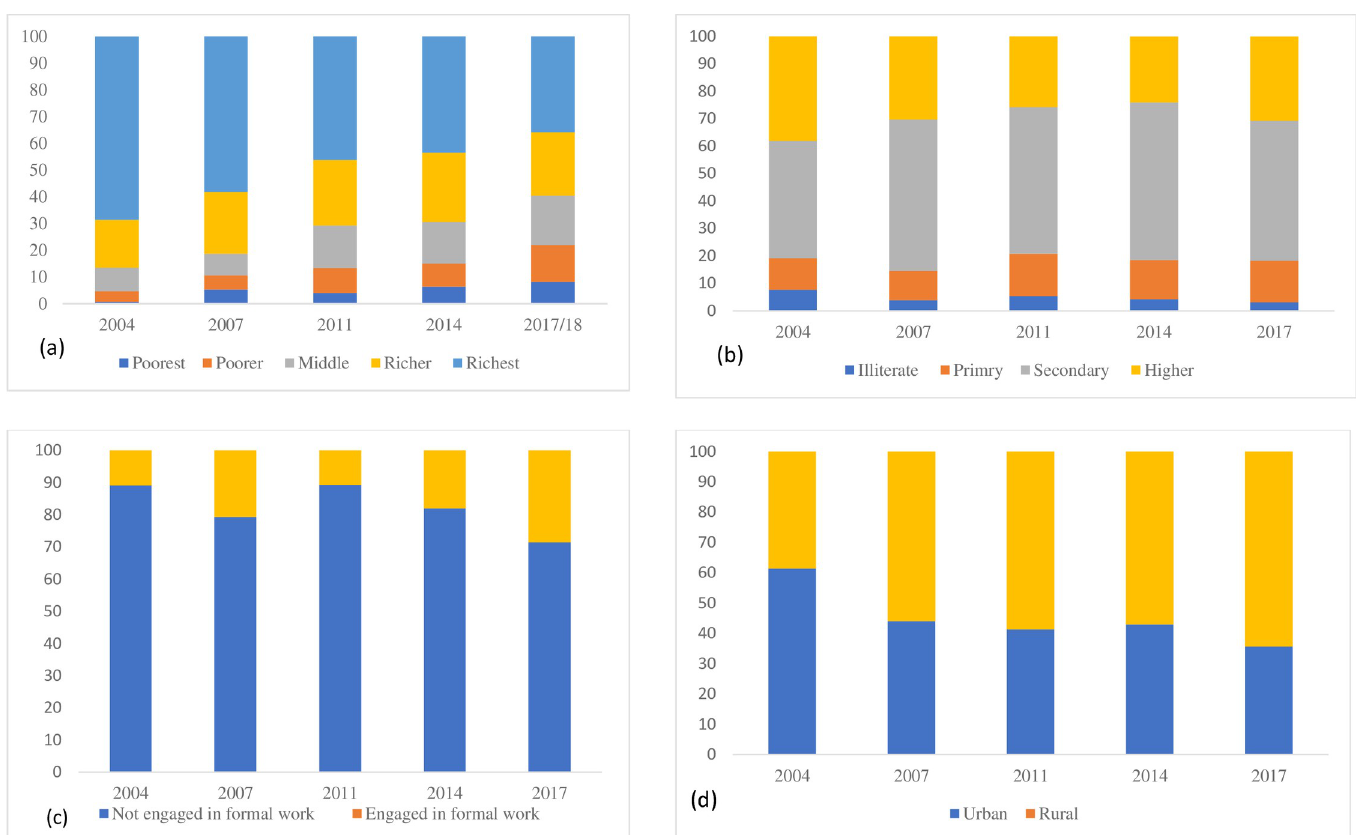
Fig 3. (a-d) Distribution of Socioeconomic Status among women having caesarean section use in Bangladesh, 2004-2017/18.